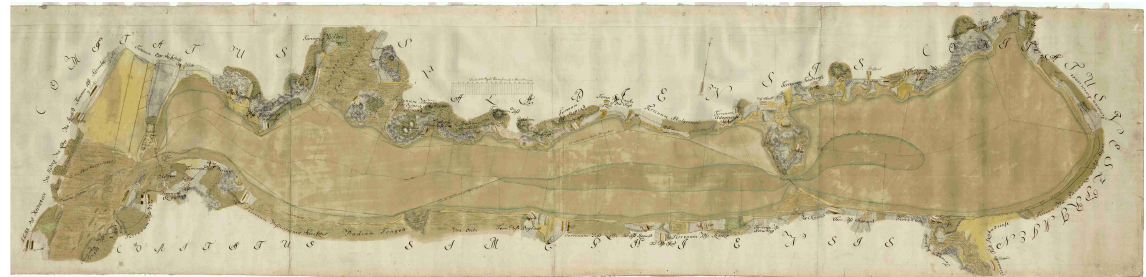
Fig. 2. Krieger’s map of Lake Balaton